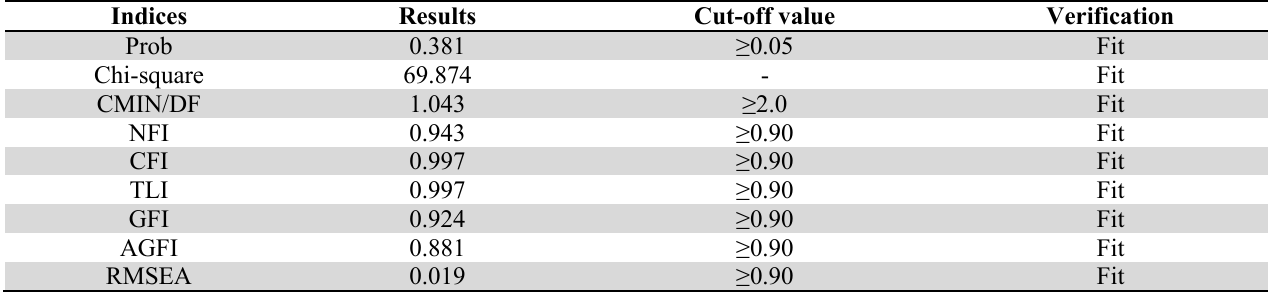
Goodness-of-Fit Test Indices Results Cut-off value